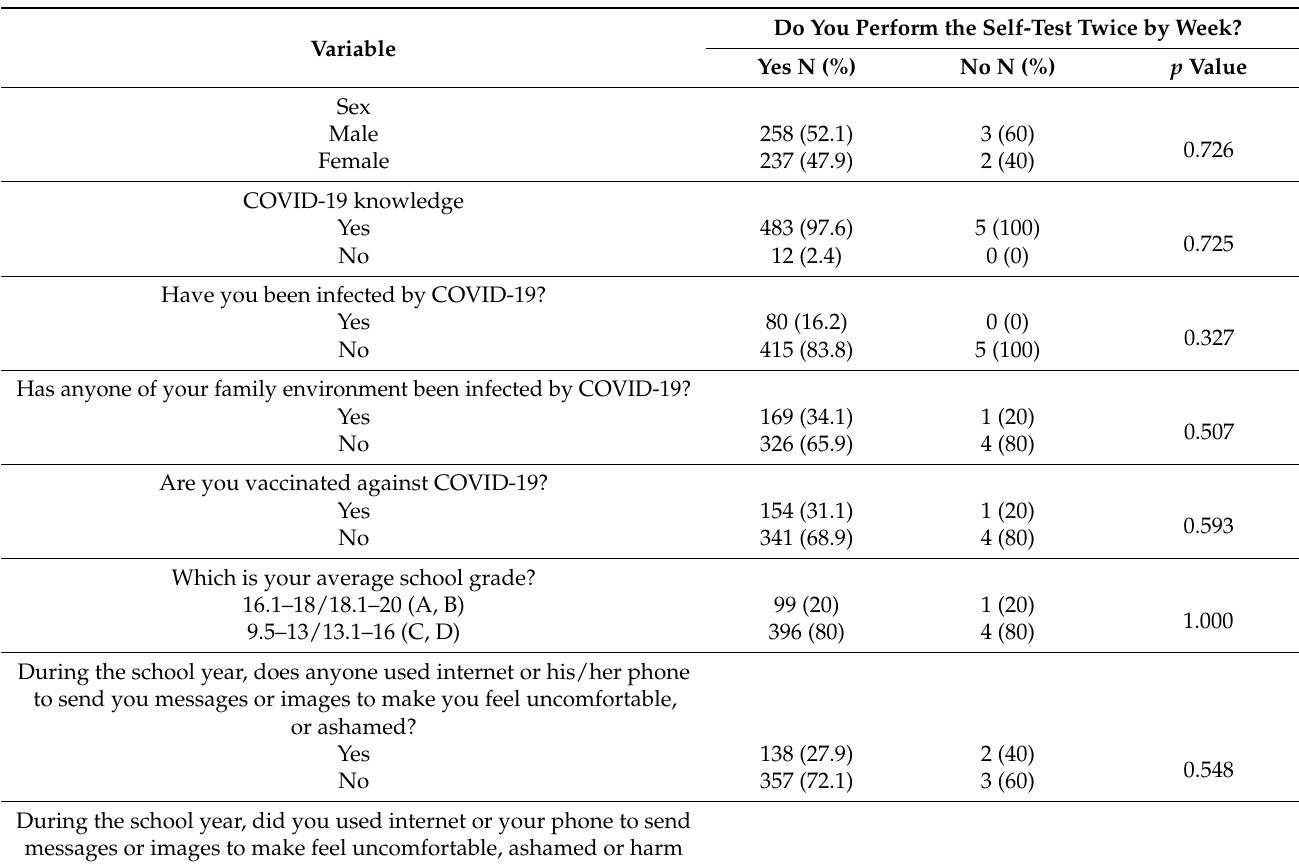
Table 2. Univariate analysis of COVID 19 self-test practice for students aged 13–15 y.o. Variable